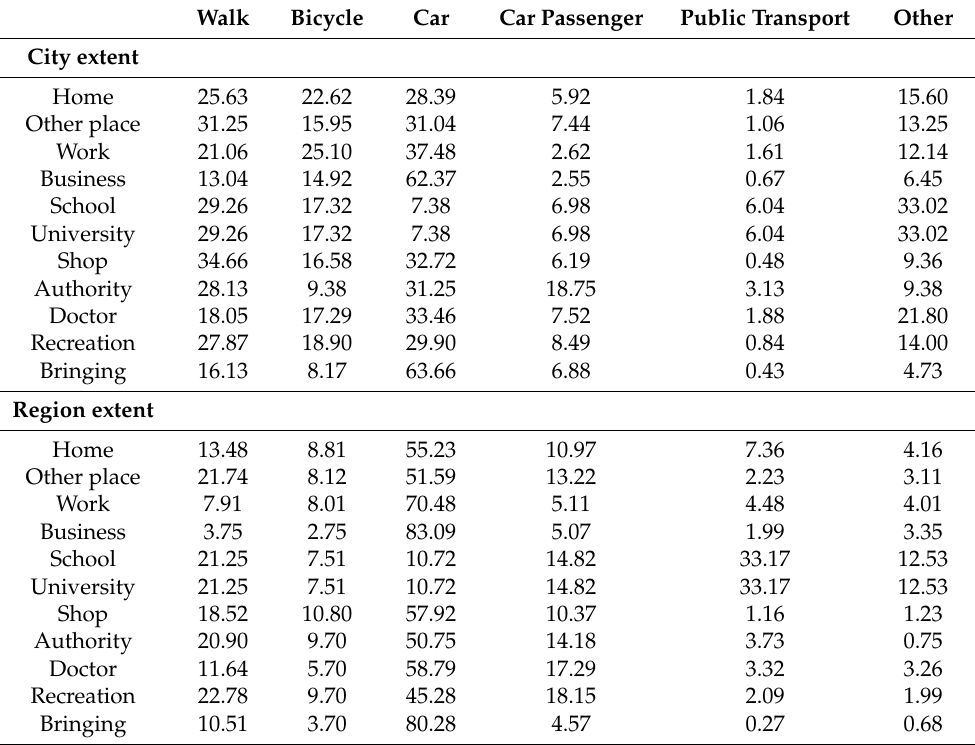
Table 2. Probability distributions of modes (%) by activity type and extent. Walk Bicycle Car Car